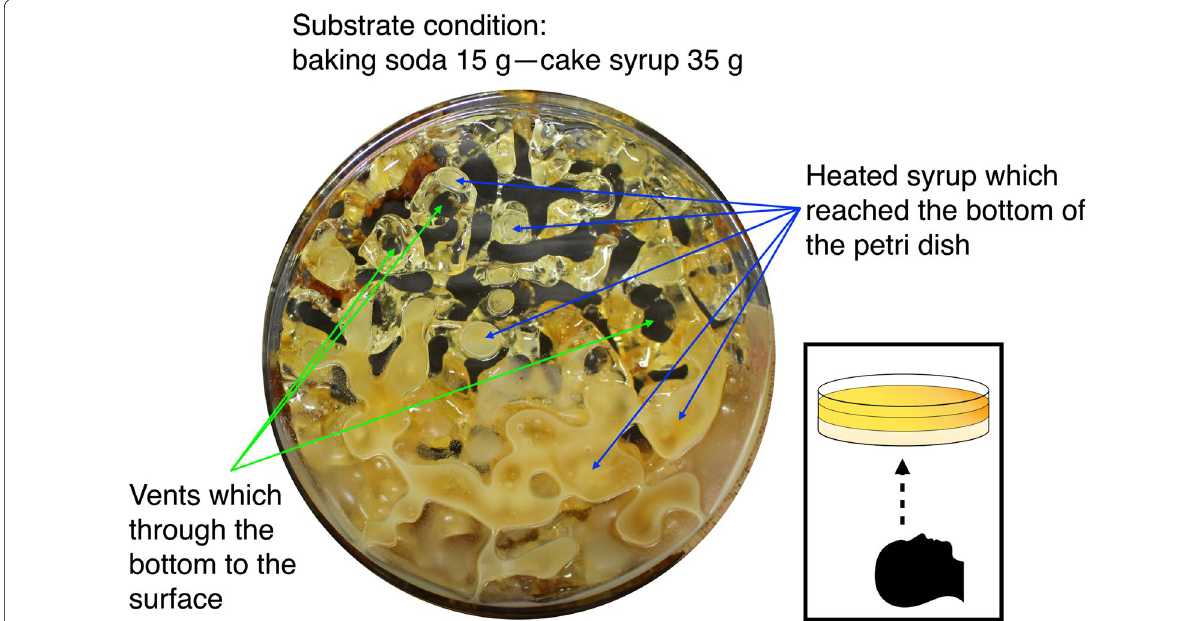
Fig. 3 Photograph of the petri dish after the experiment taken from below the dish. The substrate was removed. The heated syrup sank and sparsely reached the bottom of the petri dish. The substrate consisted of 15 g of baking soda and 35 g of cake